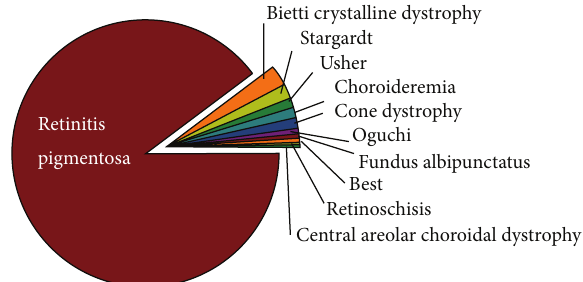
Figure 2: Retinal dystrophies included in this study. Clinical diagnosis of each retinal disease is shown. Nonsyndromic RP was found in 313 of 349 cases at the rate of 89.6%. We revised the clinical diagnosis in one case after genotyping: the patient diagnosed with cone dystrophy was revised to autosomal recessive enhanced S-cone syndrome (ESC) due to compound heterozygous NR2E3 mutations: c.419A > G and c.488T > C.